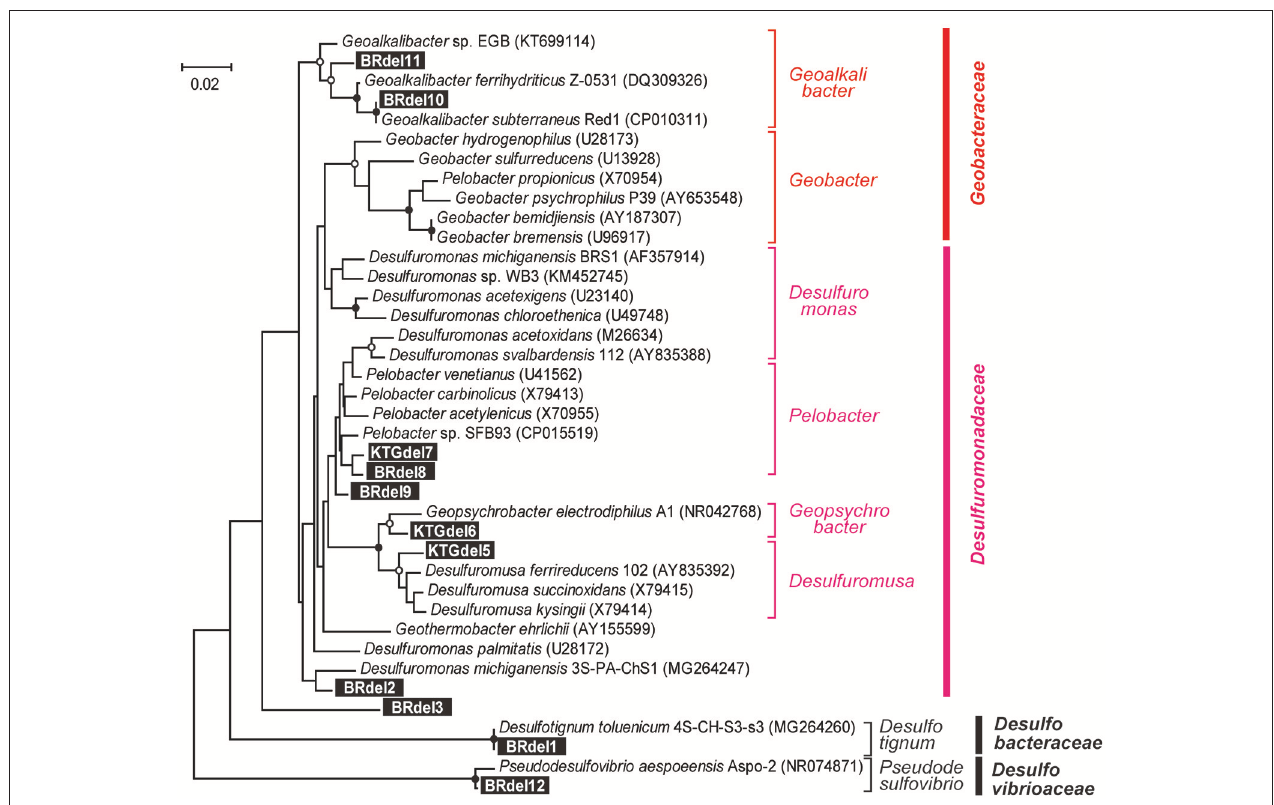
FIGURE 7 | Maximum likelihood based phylogenetic trees showing positions of major DIET-related Deltaproteobacteria OTUs representing anodic electrogenic microbial populations. Branch points supported with bootstrap values (100 trials) of > 90% are indicated with closed circles, while those between 70 and 90% are indicated with open circles. Accession numbers of reference sequences are indicated in